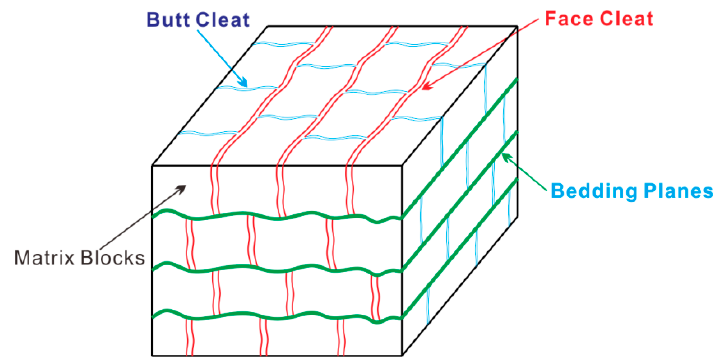
Figure 16. Anisotropic structure of coal.